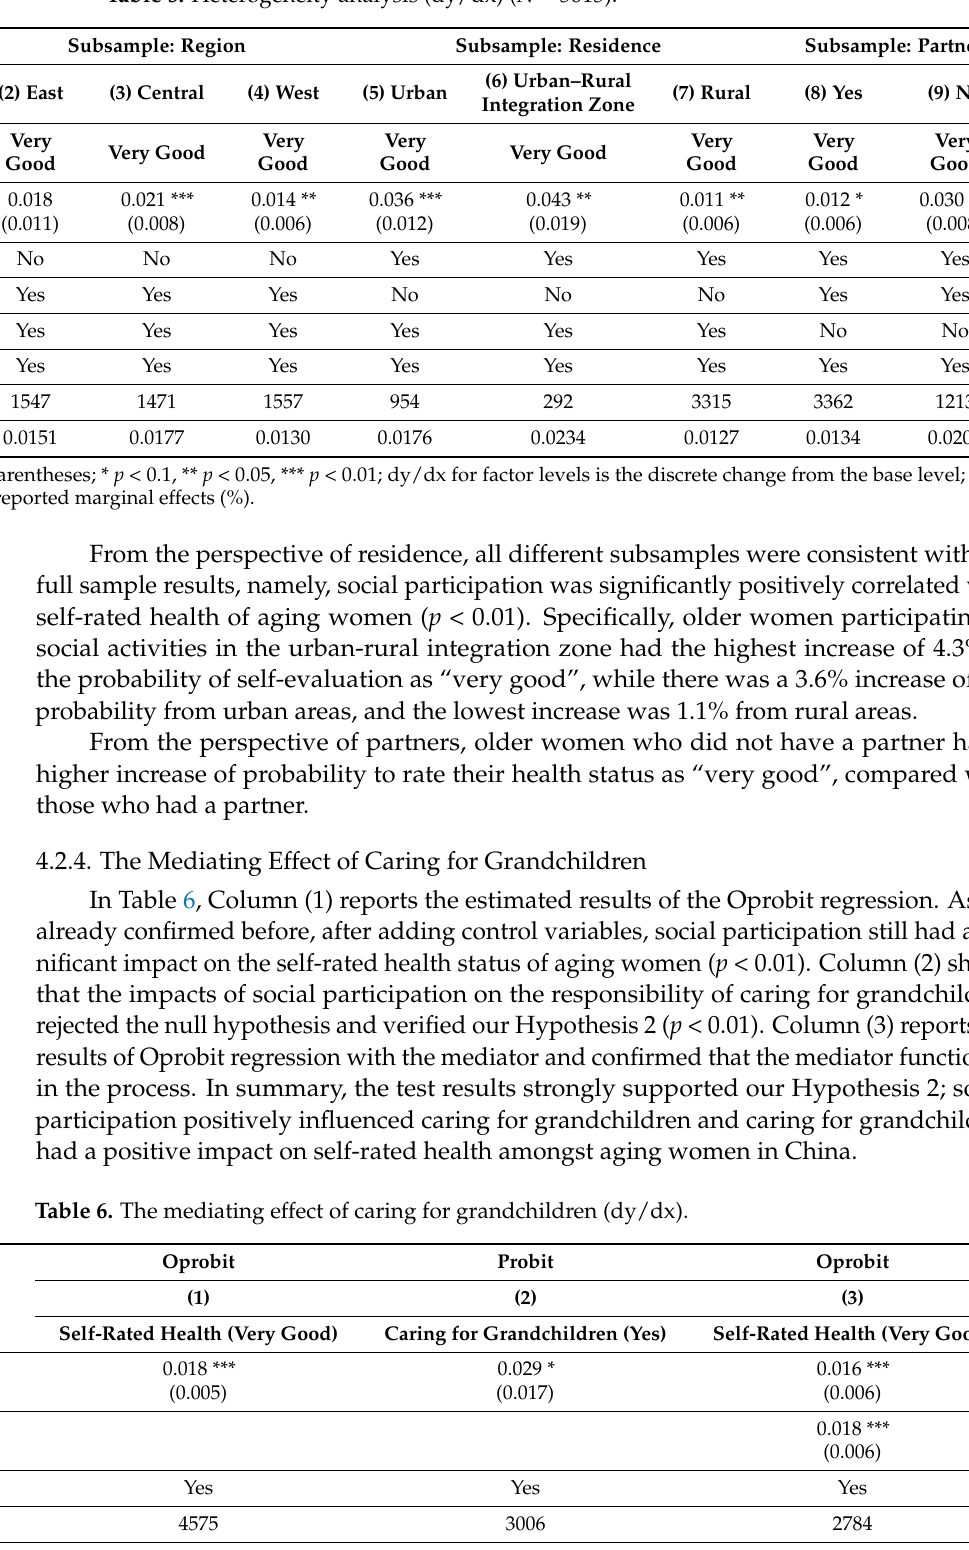
Table 5. Heterogeneity analysis (dy/dx) ( N = 5015).